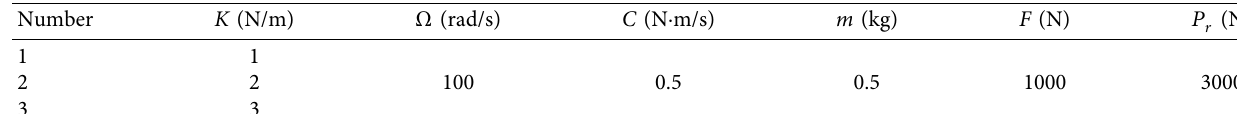
Figure 2: Changes of vibration displacement of different rocks with time. Table 1: Calculation